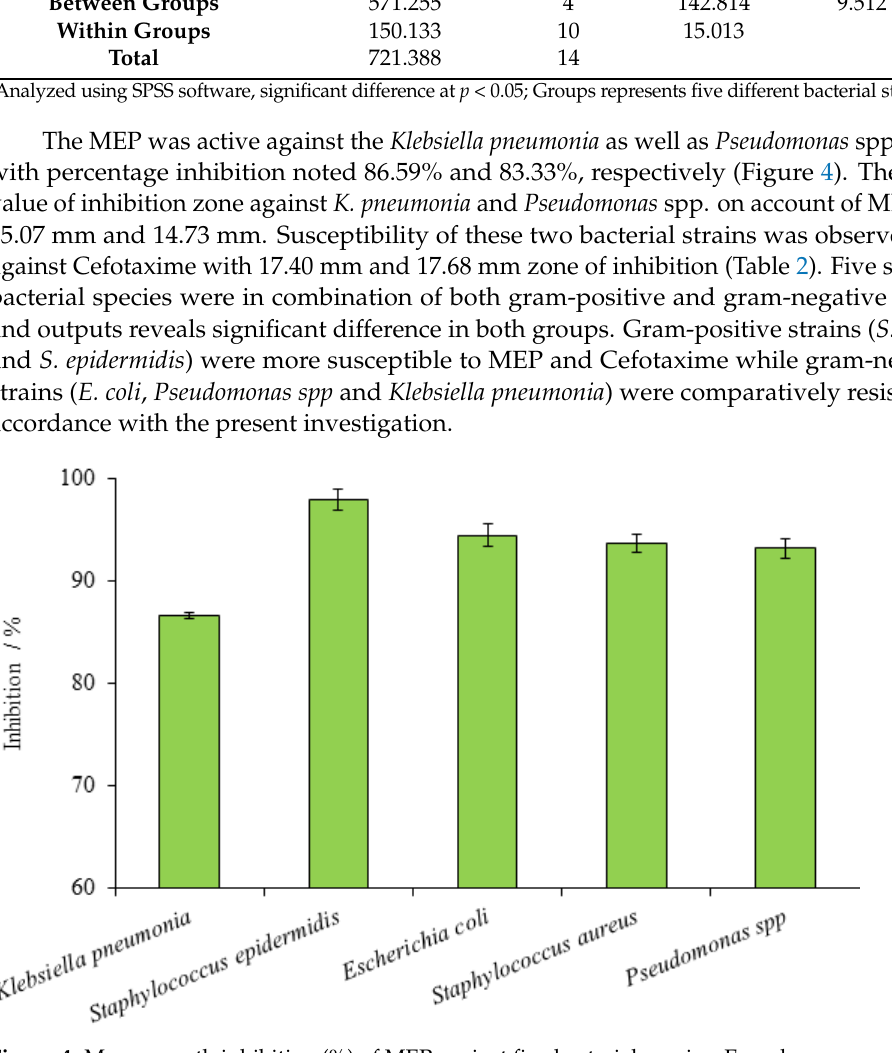
Figure 4. Mean growth inhibition (%) of MEP against five bacterial species. Error bars represent SEM values of results from three replicate experiments.